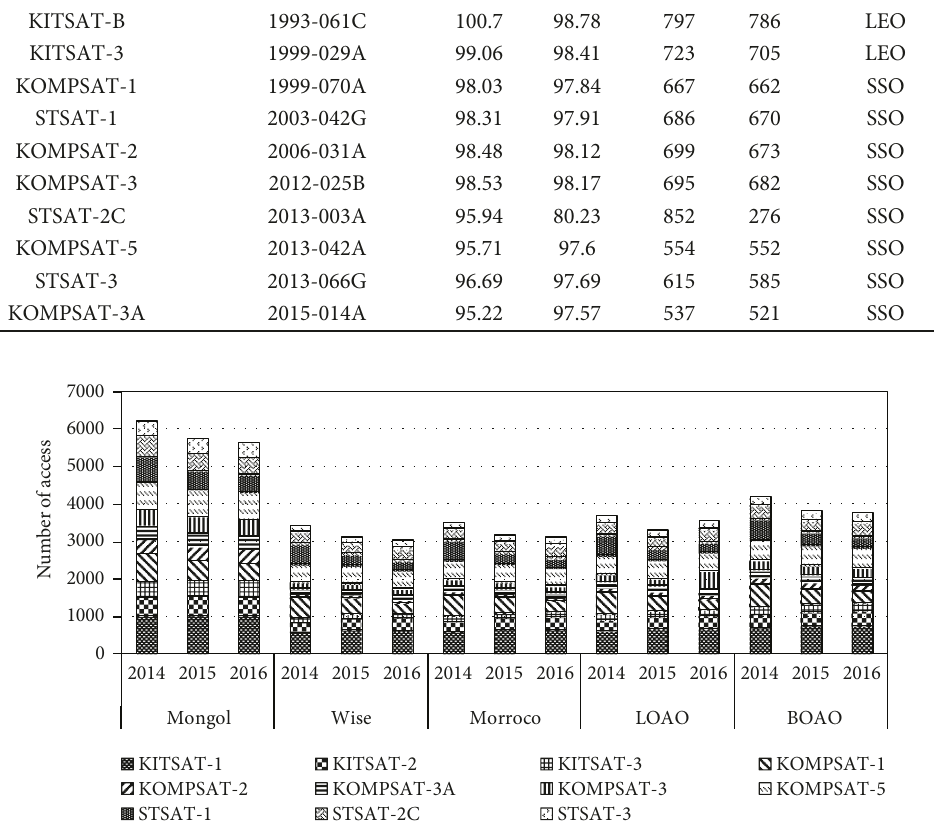
Figure 2: Number of accesses for the 11 LEO observation targets at OWL-Net from 2014 to